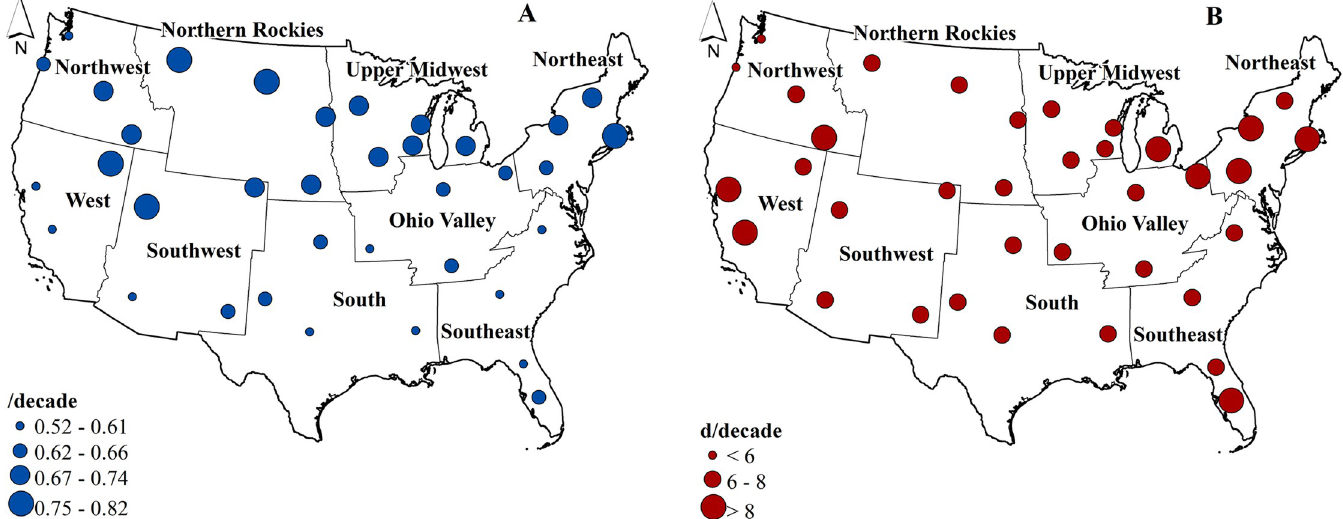
Fig 3. Projected decadal increases in average Temperature Humidity Index (A) and annual Heat Stress Frequency (B) between 2000 to 2100 (Boundary data [31]).